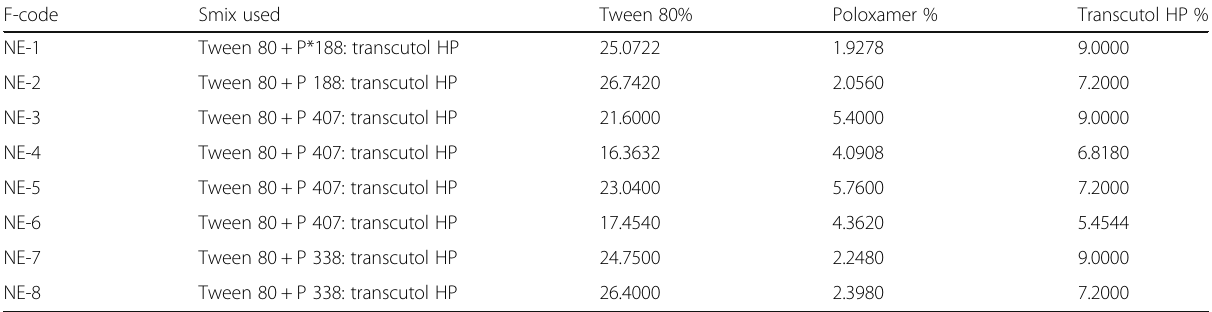
Table 2 Composition (%w/w) of Smix of different candesartan cilexetil nanoemulsions F-code